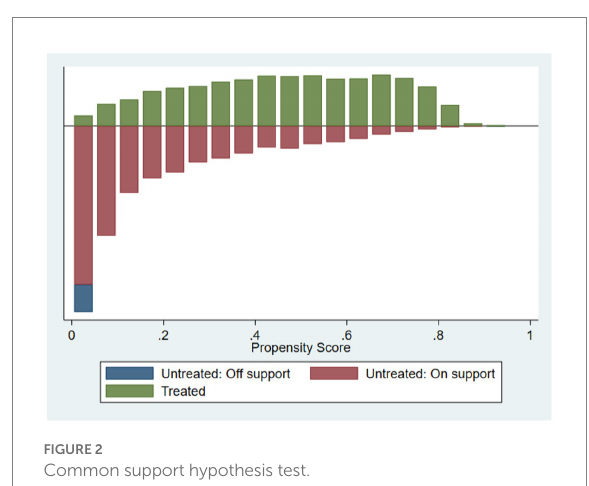
FIGURE 2 Common support hypothesis